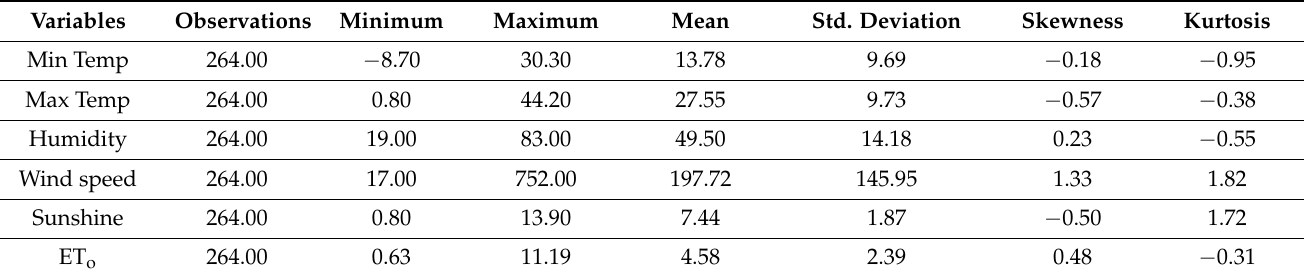
Table 1. Statistical information on the available climatic